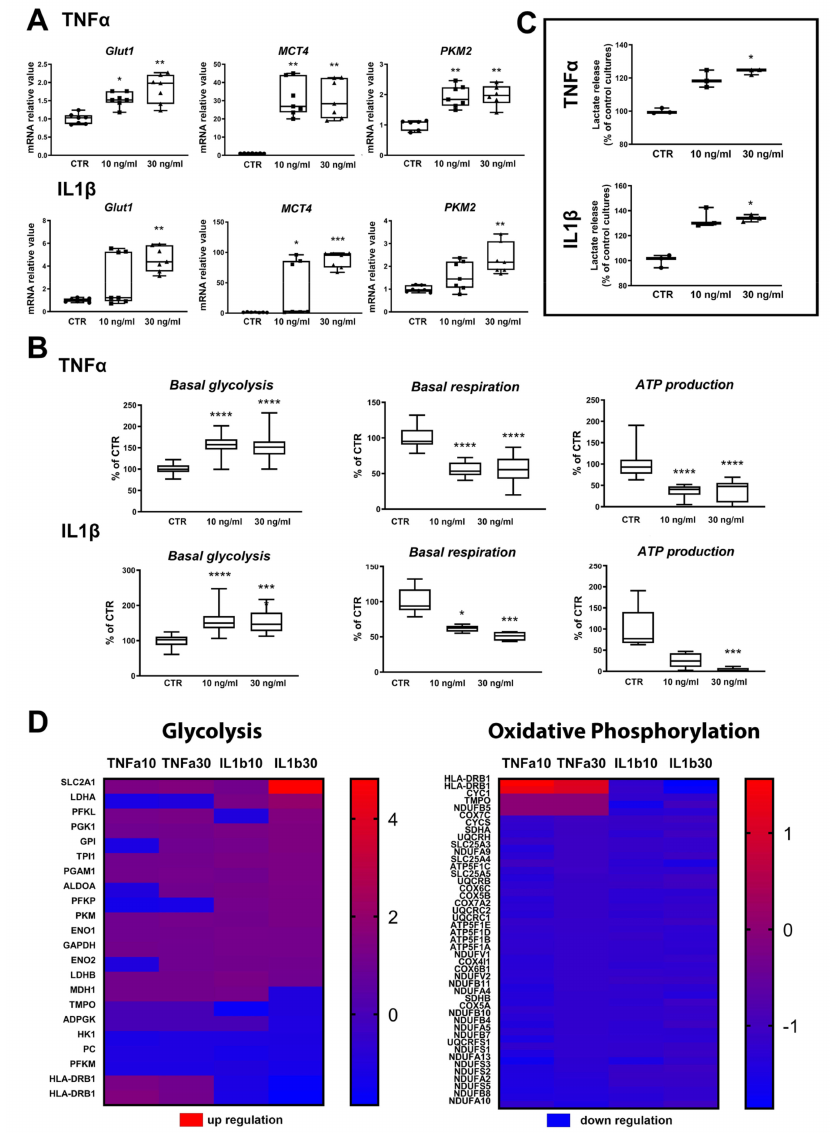
Figure 6. Exposure to cytokines leads to increased glycolysis in ReN-derived astrocytes. ( A ) Changes in genes related to energy metabolism after 24 h of exposure to TNF α or to IL1 β . ( B ) Basal glycolysis rate after TNF α ( n = 48 per group) or IL1 β ( n = 42 per group); basal respiration after TNF α (control: n = 18, 10 ng/mL: n = 14, 30 ng/mL: n = 13) or IL1 β (control: n = 19, 10 ng/mL: n = 5, 30 ng/mL: n = 6); and ATP production after TNF α (control: n = 17, 10 ng/mL: n = 14, 30 ng/mL: n = 13); and after IL1 β (control: n = 8, 10 ng/mL: n = 5, 30 ng/mL: n = 6); ( C ) Lactate release after 24 h of exposure to TNF α or IL1 β . n = 3 per group. Results are displayed as boxplots with data points. The line in the box indicates the median, whereas top and bottom of the box represent the 75th and 25th percentiles; whiskers extend from minimum to maximum values. Statistical analysis was performed by using Kruskal–Wallis test followed by Dunn’s multiple comparisons test. * p < 0.05; ** p < 0.01; *** p < 0.001; **** p < 0.0001. ( D ) Abundance of proteins significantly changed after 24 h of exposure to TNF α or IL1 β as compared to control cultures in glycolysis and oxidative phosphorylation pathways. Red: upregulated, blue: downregulated. Scales indicate fold change compared to control